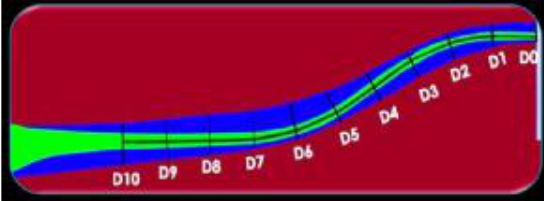
Figure 3: Measurement Levels on Image in AutoCAD Program